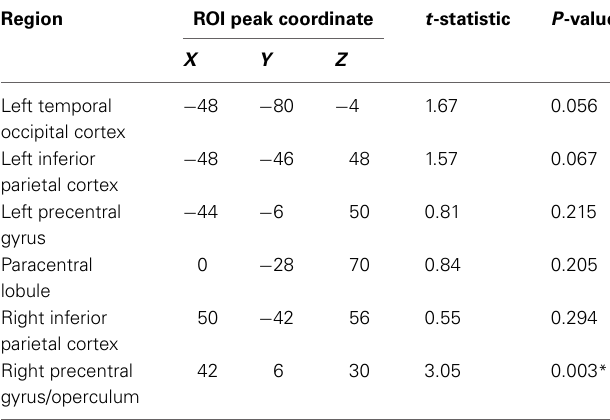
FIGURE 5 | Brain activity for judgments regarding shape or color, across all three groups of subjects (voxelwise p < 0 . 001, cluster-level corrected q < 0 . 05). (A) Activity for shape judgments. (B) Activity for color judgments. (C) Comparison of activity for shape and color judgments. The task × group interaction was not significant. Table 3 | Increased gray matter volume in better performing older adults relative to worse performing older